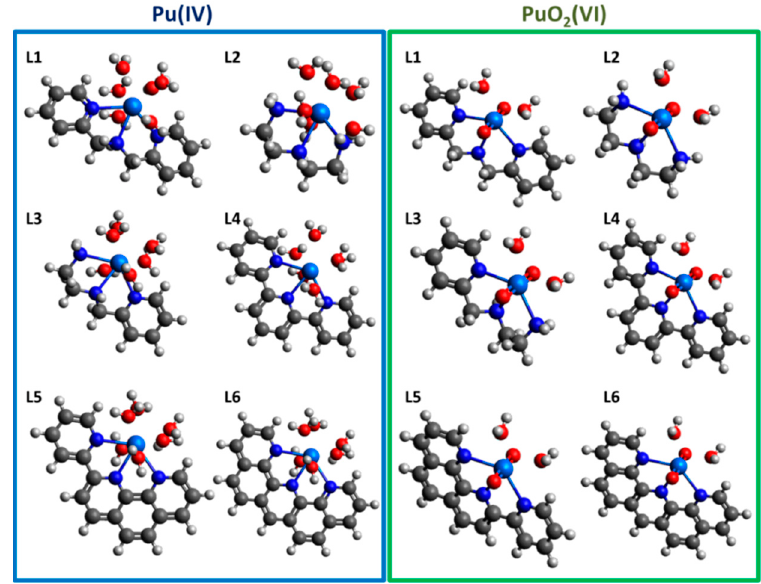
Figure 2. Optimized structures of Pu (IV) and PuO 2 (VI) with the suggested nitrogen tridentate ligands in aqueous solution (structural chemical formulas and coordinates of all structures are listed in SI).